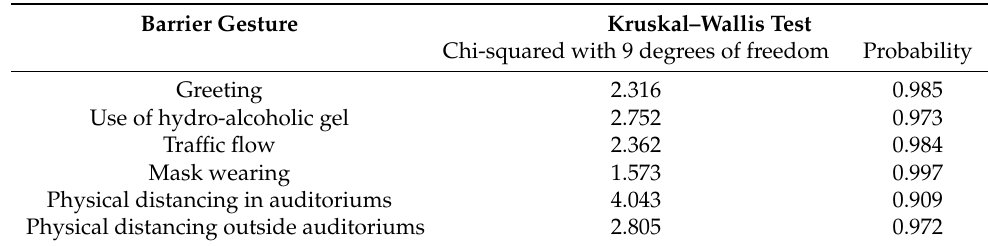
Table 5. Effect of the composition of the panel of experts on the weight of each gesture barrier contributing to SARS-CoV-2